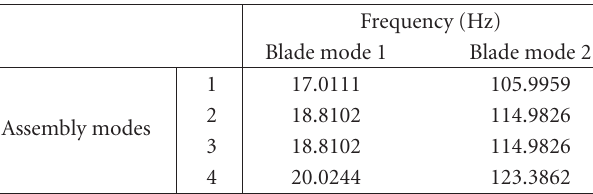
Table 2: Natural frequencies of assembly modes in